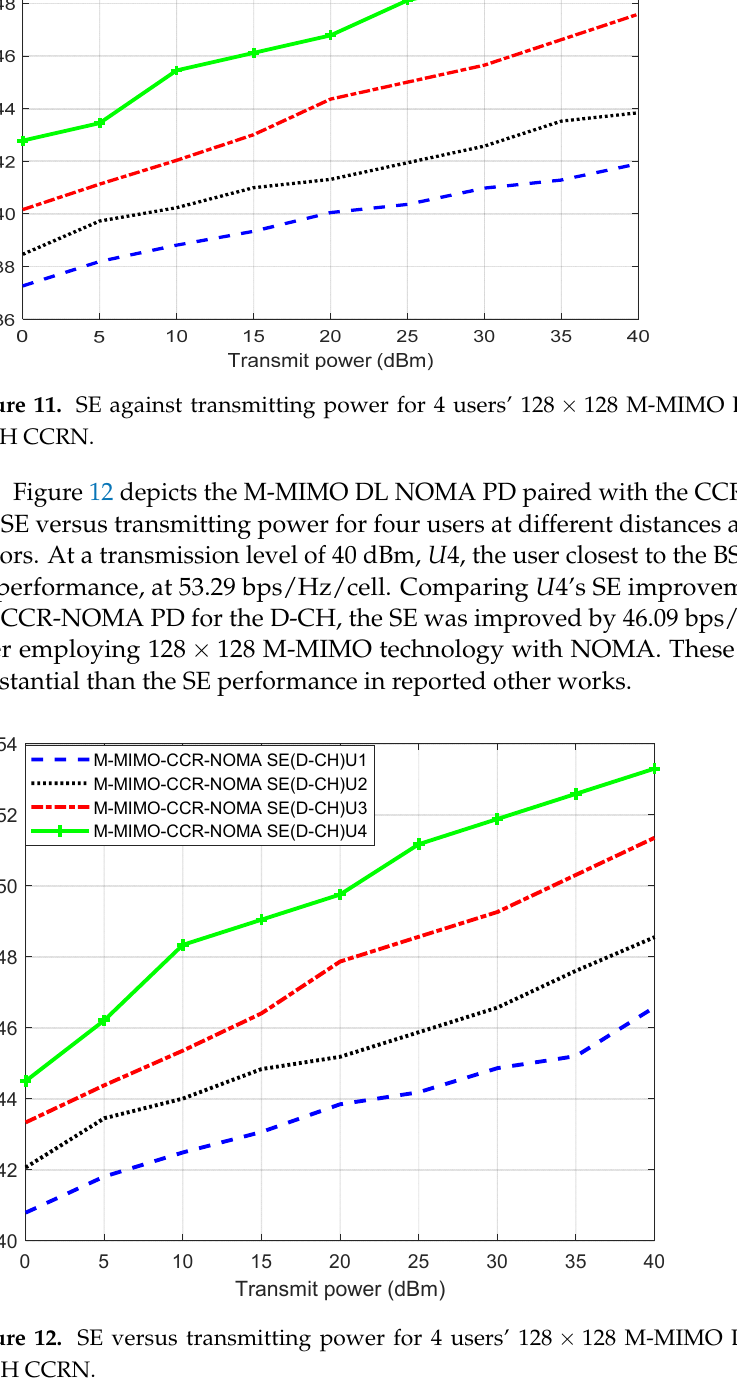
Figure 10. SE vs. transmitting power for 4 users’ 128 × 128 M-MIMO DL NOMA PD.